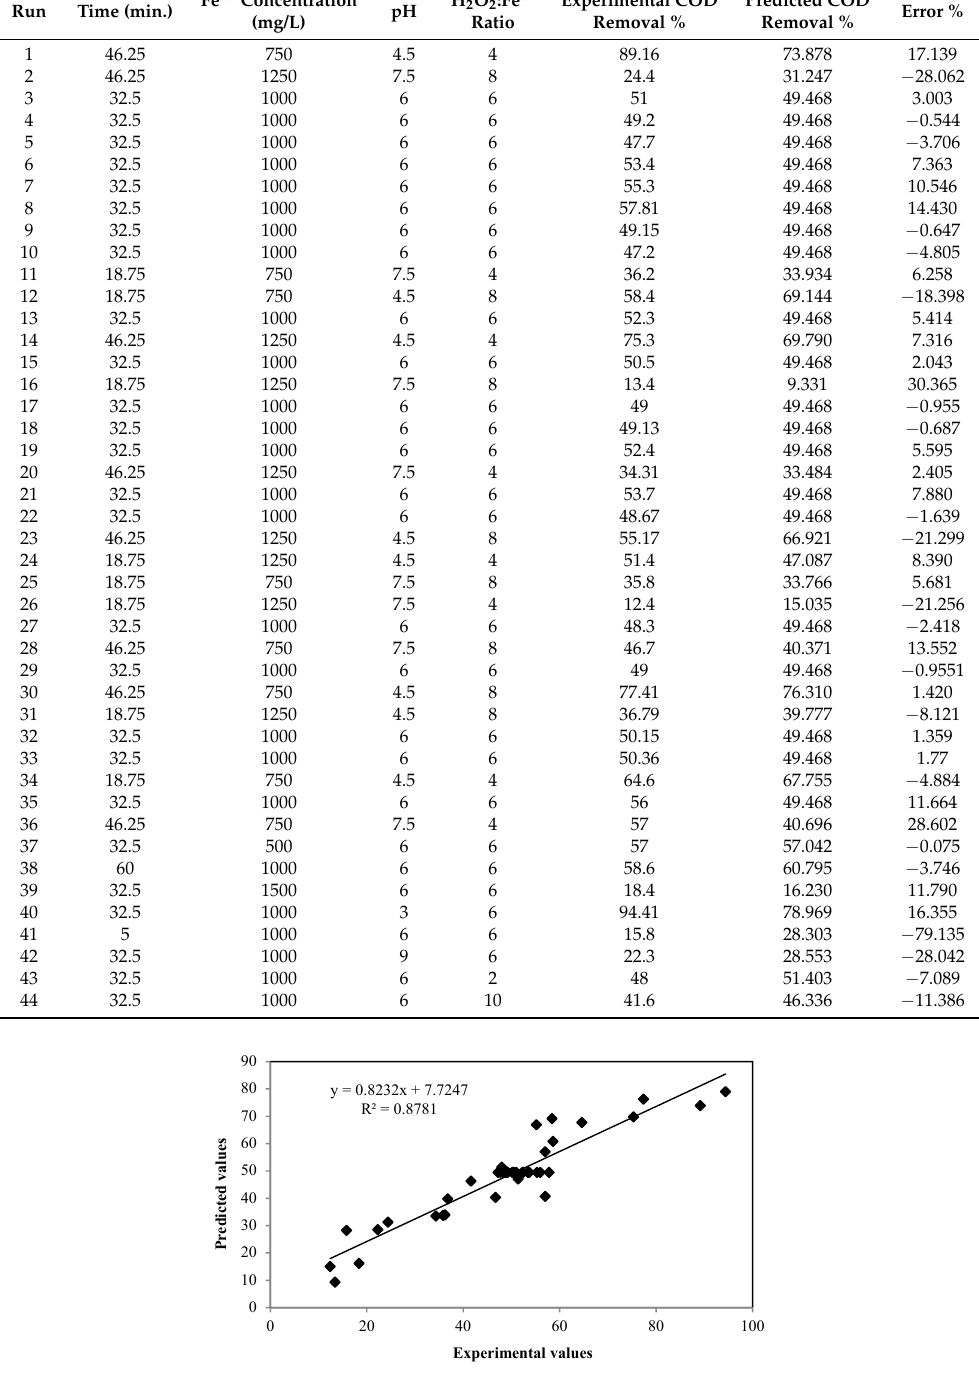
Figure 3. Predicted versus actual values plot for COD removal using the ANN model.